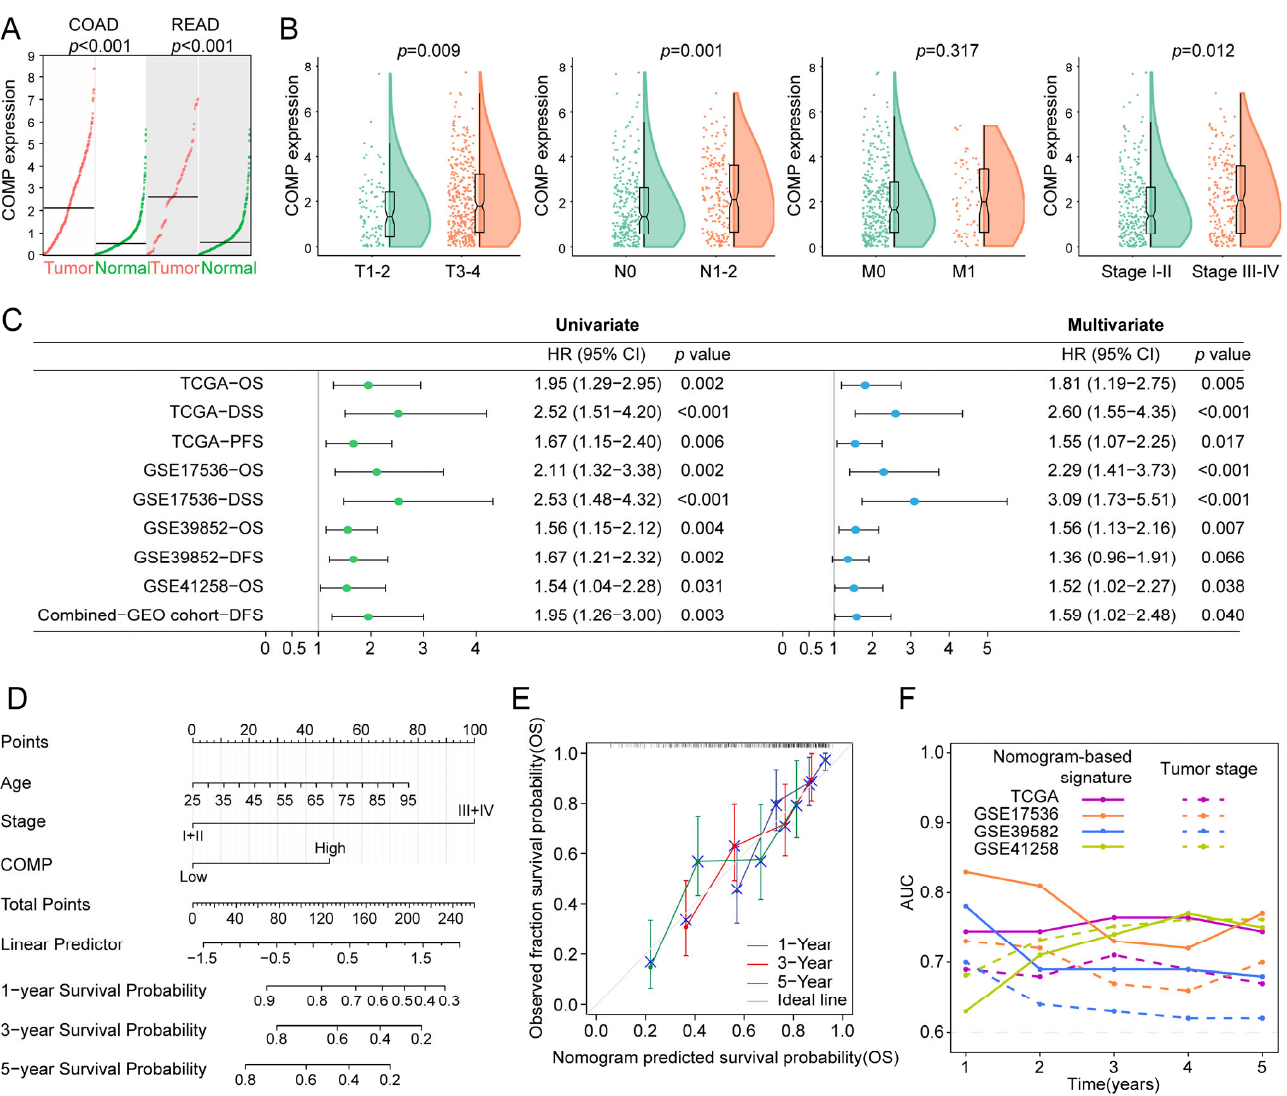
Figure 3. Evaluation and validation of the prognostic value of COMP. ( A ) Analysis of COMP expression between tumor and normal control specimens in COAD and READ; ( B ) Comparison of COMP expression in different T, N, M, and TNM stages; ( C ) Forest plot of Cox analysis. For multivariate analysis in the TCGA dataset, the HR value of COMP level was adjusted by age, gender, and T stage. As for GSE17536, GSE39582, GSE41258, and the combined ‐ GEO dataset, HR value of COMP level was adjusted by age, gender, TNM stage, and grade; age, gender, and TNM stage; age and gender; age, gender, and TNM stage, respectively; ( D ) Nomogram for predicting the OS of patients with colon cancer; ( E ) Calibration curves display the agreement between predicted OS and actual survival duration; ( F ) Time ‐ dependent AUC plotted for different durations of OS for nomogram ‐ based signature and tumor stage in the TCGA, GSE17536, GSE39582, and GSE41258 datasets.